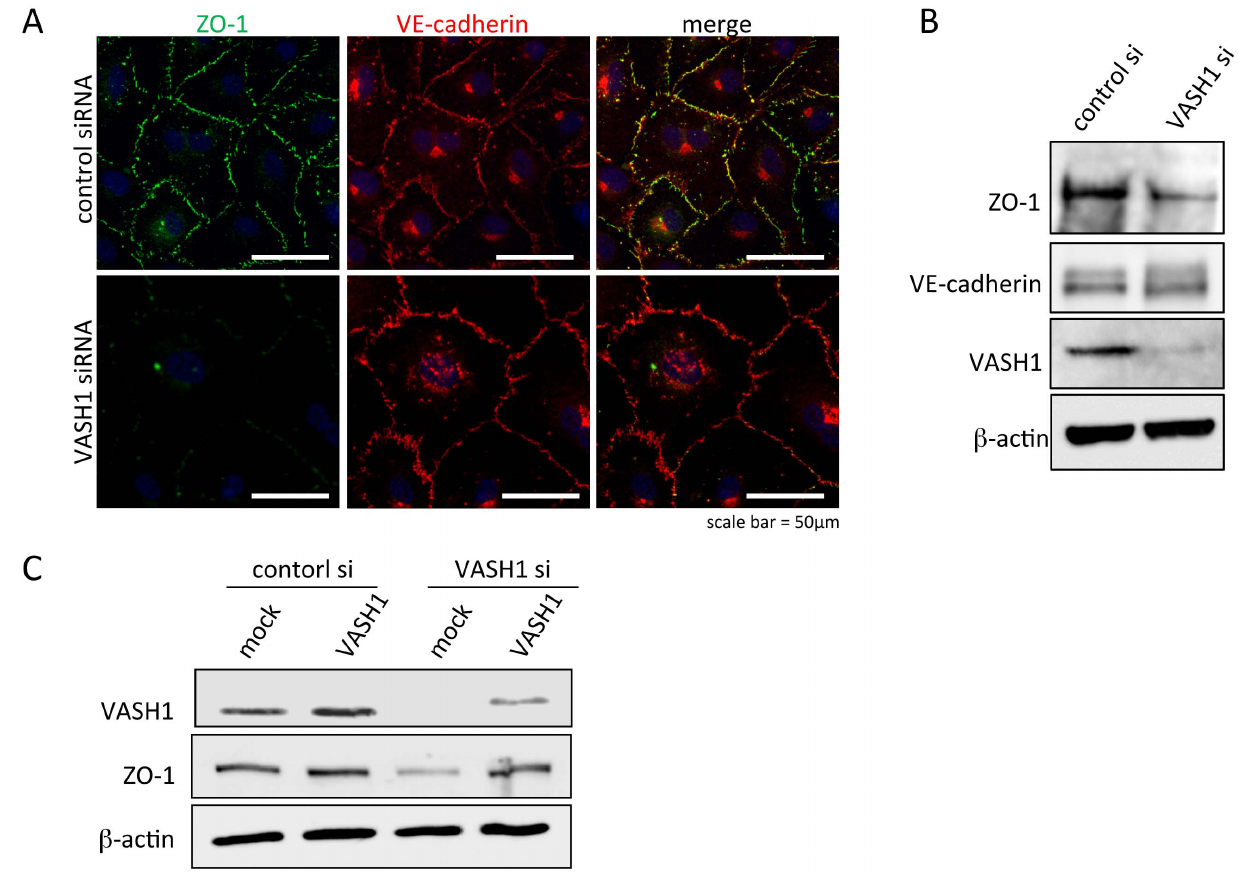
Figure 8. Cell-cell junctions of HUVECs. Seventy-two hours after the siRNA treatment, immunostaining for ZO-1 and VE-cadherin, components of tight junctions and adherence junctions, respectively, in HUVECs treated with control siRNA or VASH1 siRNA was performed. Bar=50 m m. B: Protein content of ZO-1, VE-cadherin, VASH1, and b -actin in HUVECs treated with control siRNA or VASH1 siRNA was analyzed by Western blotting. C: HUVECs were transfected with the VASH1 expression vector, and stealth siRNA. The cells were extracted 48 hours later, and Western blot analysis was performed.